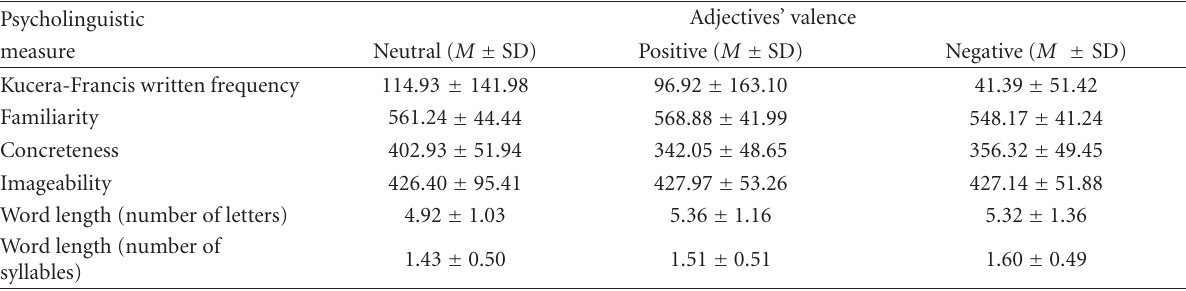
Table 2: Psycholinguistic properties of adjectives used in the